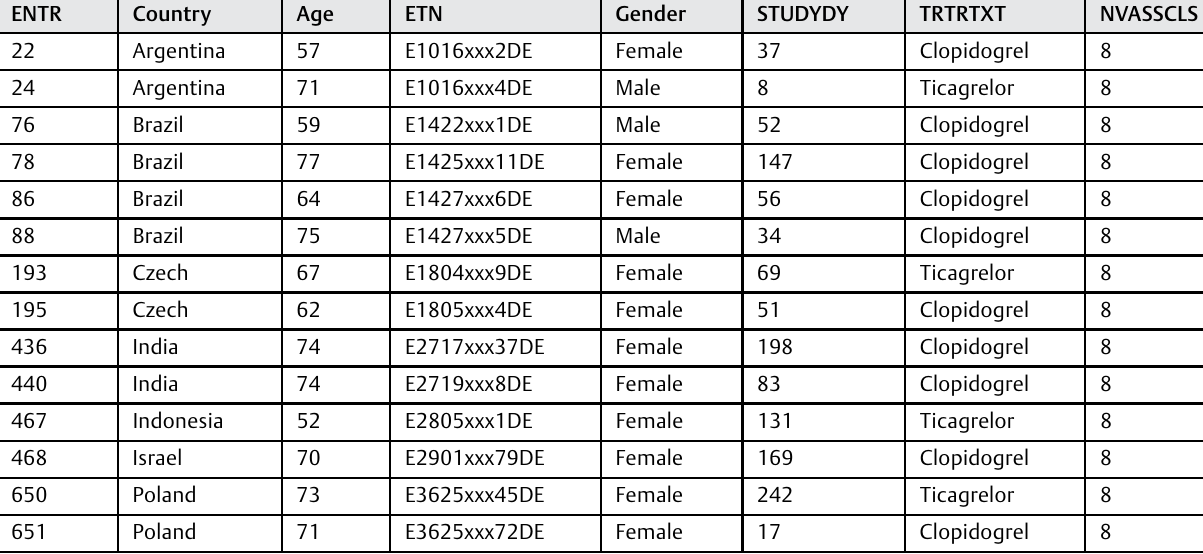
Table 2 FDA-issued dataset entries for questionable sepsis deaths in PLATO trial